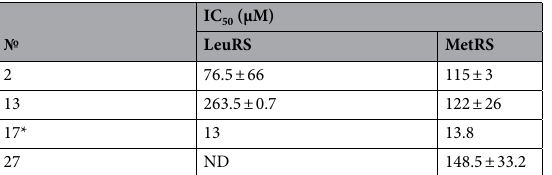
Table 2. IC 50 values of dual-target compounds against M. tuberculosis LeuRS and MetRS. The shown data represent mean values ± s.d. (n = 3). *Data of IC 50 for compound 17 from the previous article 22 . ND not determined.